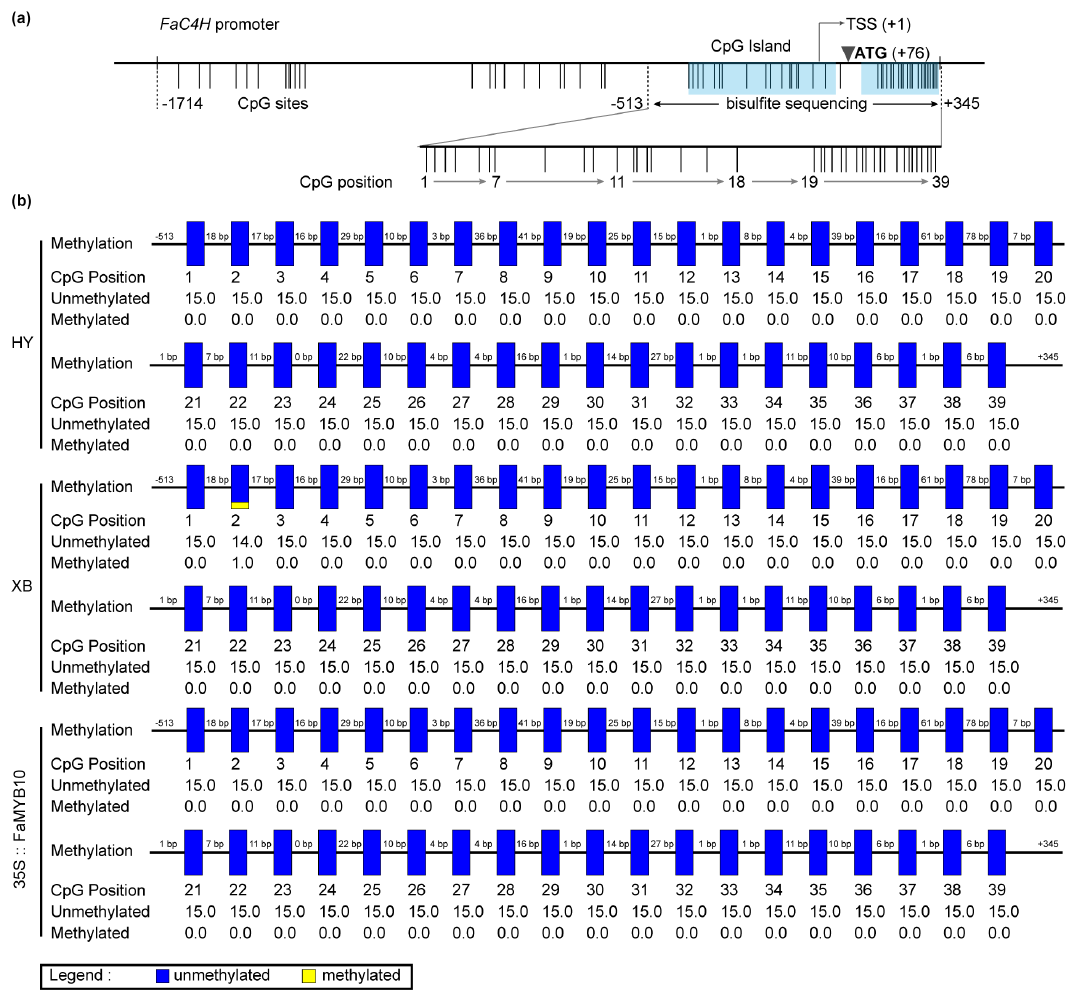
Figure 5. The CpG site analysis and methylation detection of FaC4H promoter in the flesh of Benihoppe (HY), Xiaobai (XB), and 35S::FaMYB10. ( a ) Analysis of the CpG sites in FaC4H promoter by MethPrimer. ( b ) Bisulfite sequencing of the selected 39 CpG sites in different samples. Each CpG site was sequenced from 15 different clones.